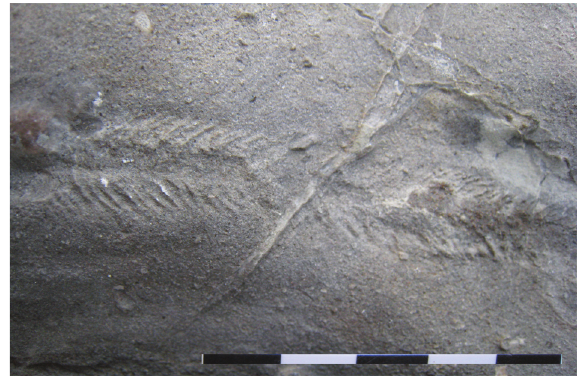
Fig. 4. Cruziana isp., Pridoli, Ohesaare Formation, Saaremaa. Scale bar division = 1 cm. TUG